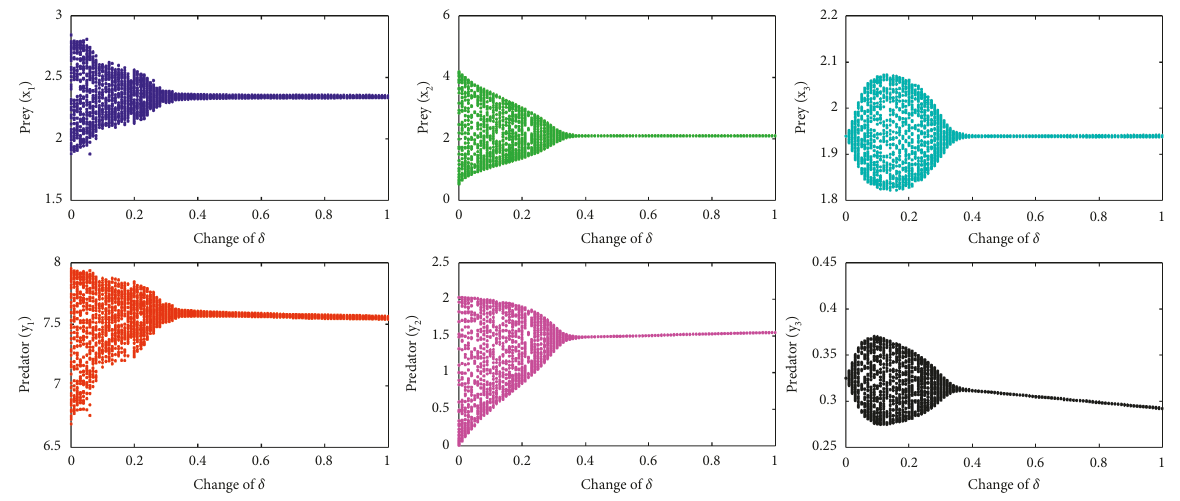
Figure 21: Bifurcation diagrams with respect to δ